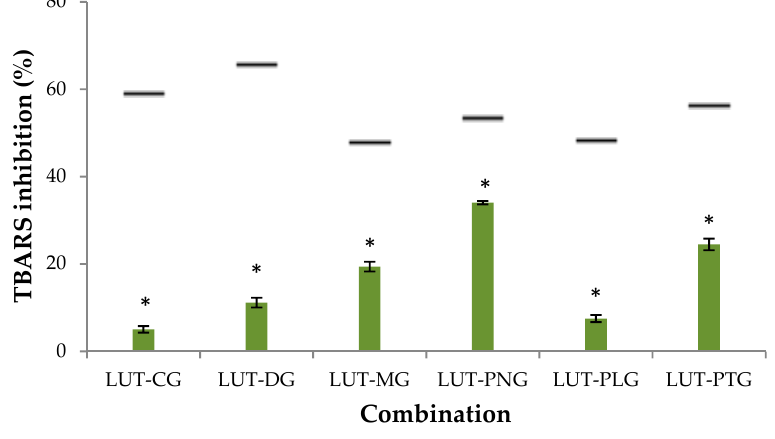
Figure 1. Liposome peroxidation inhibitory activity of different lutein-anthocyanin combinations (1:1 ratio). The horizontal lines illustrate the expected additive effect of lutein-anthocyanin combinations. Asterisk-marked columns indicate a significant difference ( p < 0.05) between the observed effect of